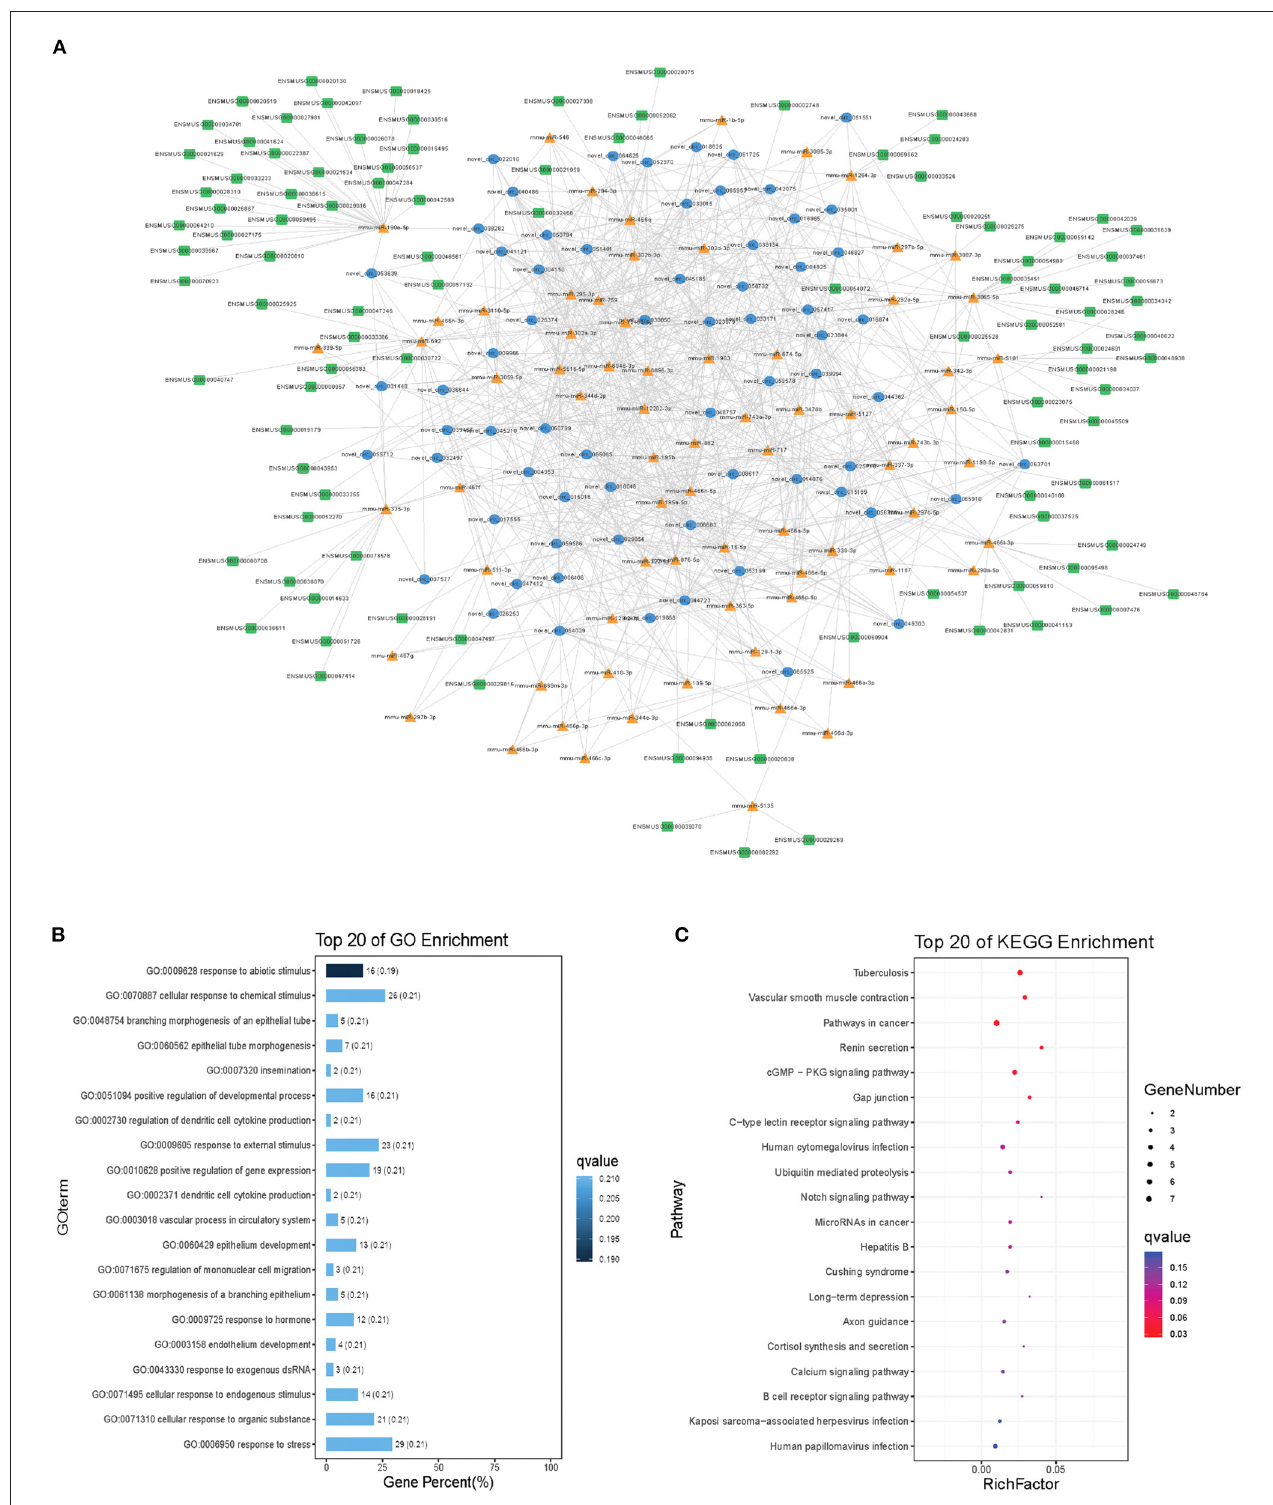
FIGURE 7 | Module 2 from the autism-related ceRNA network. (A) Module 2 network. (B) GO enrichment. (C) KEGG pathway enrichment. Circular blue, triangular orange, and square green nodes represent circRNAs, miRNAs, and mRNAs, respectively.